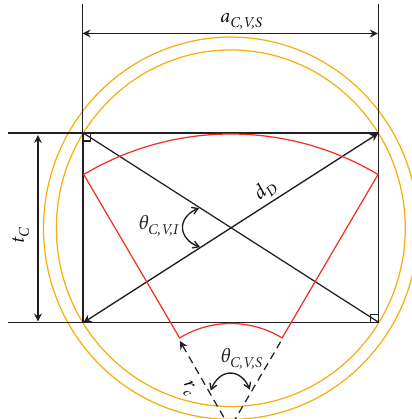
Figure 4: Top view of the piece resulting from horizontal and subsequent vertical segmentations of the cylindrical part of a spherocylinder- type object emplaced into a container together with a virtual rectangle assumed in this